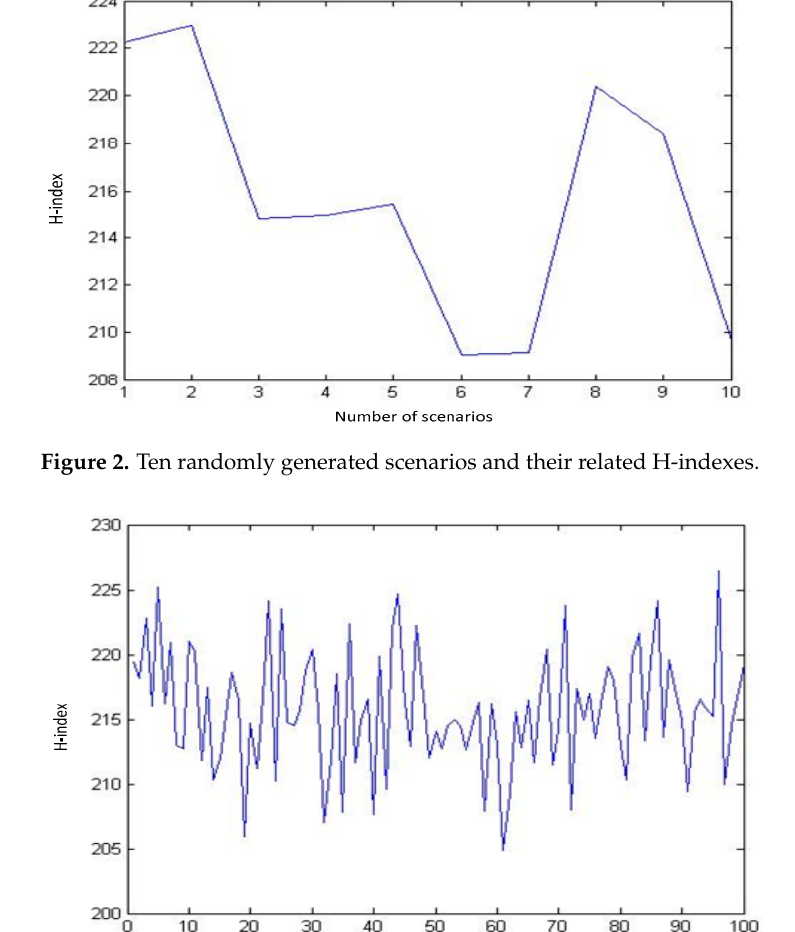
Figure 5. Three thousand randomly generated scenarios and their related H-indexes.